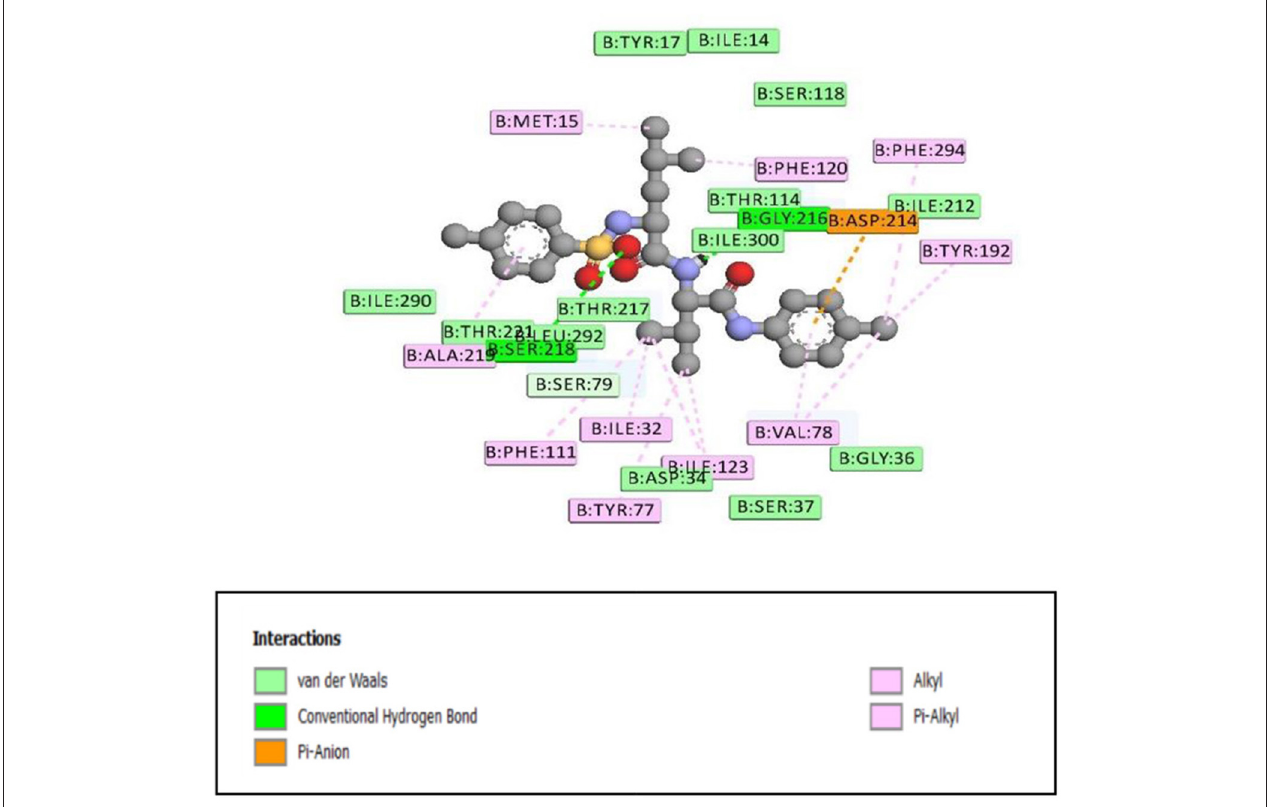
FIGURE 2 | 2D representation of binding interaction of compound 8e and the amino acid residues of 1SME.